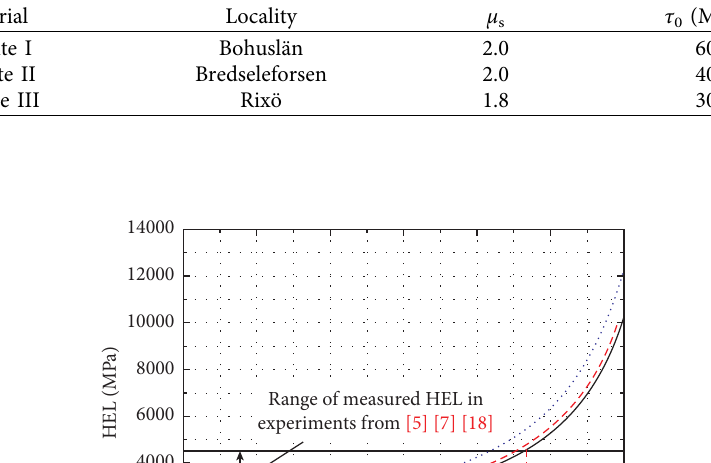
� 50MPa, ] � 0.3, τ s ( 0